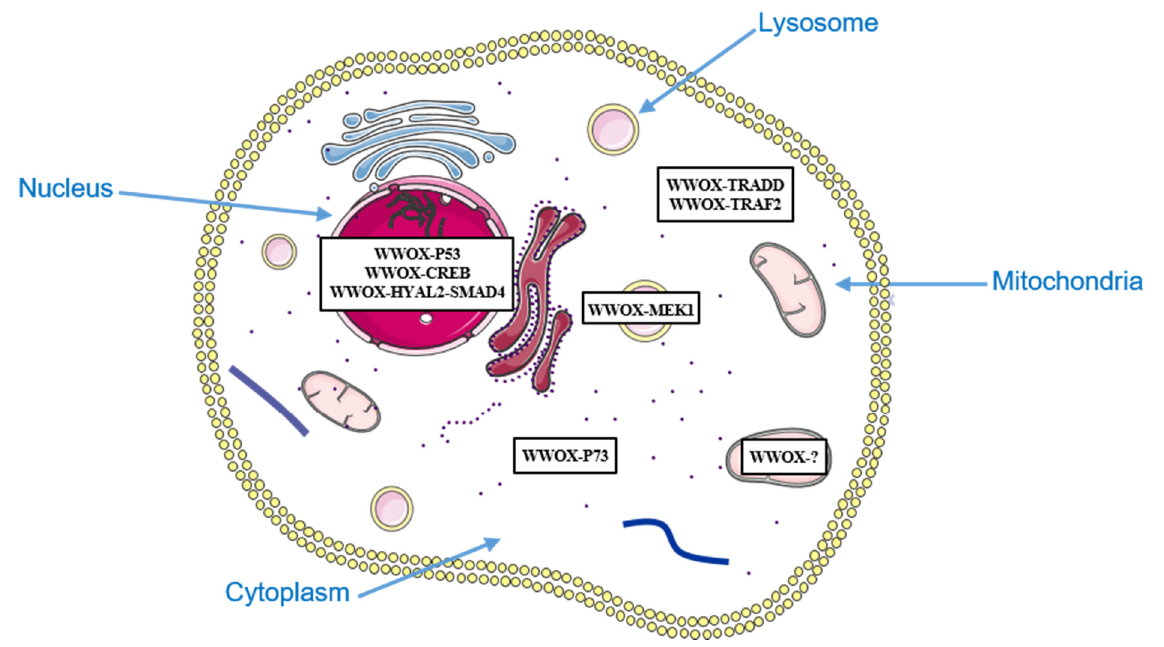
Figure 1. Subcellular localization of WWOX and its partners involved in cell death.